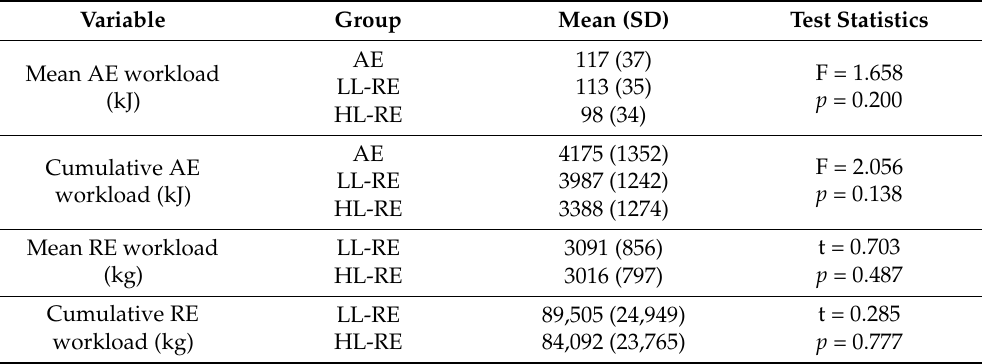
Table 3. Mean and cumulative workload during aerobic and resistance